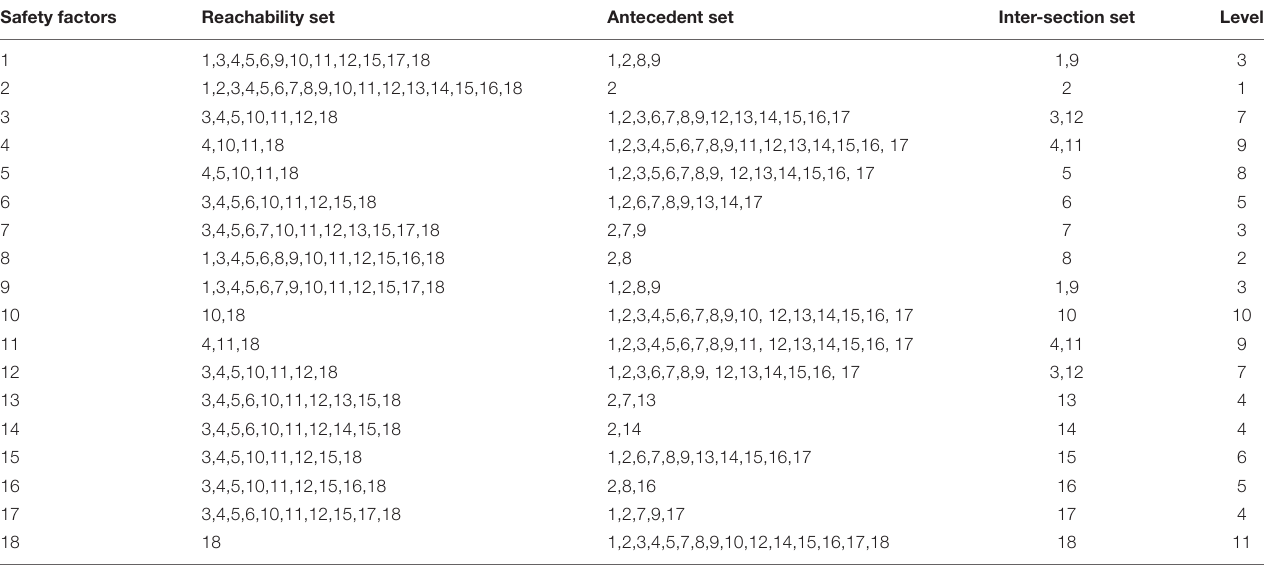
TABLE 4 | Level partitioning of the reachability